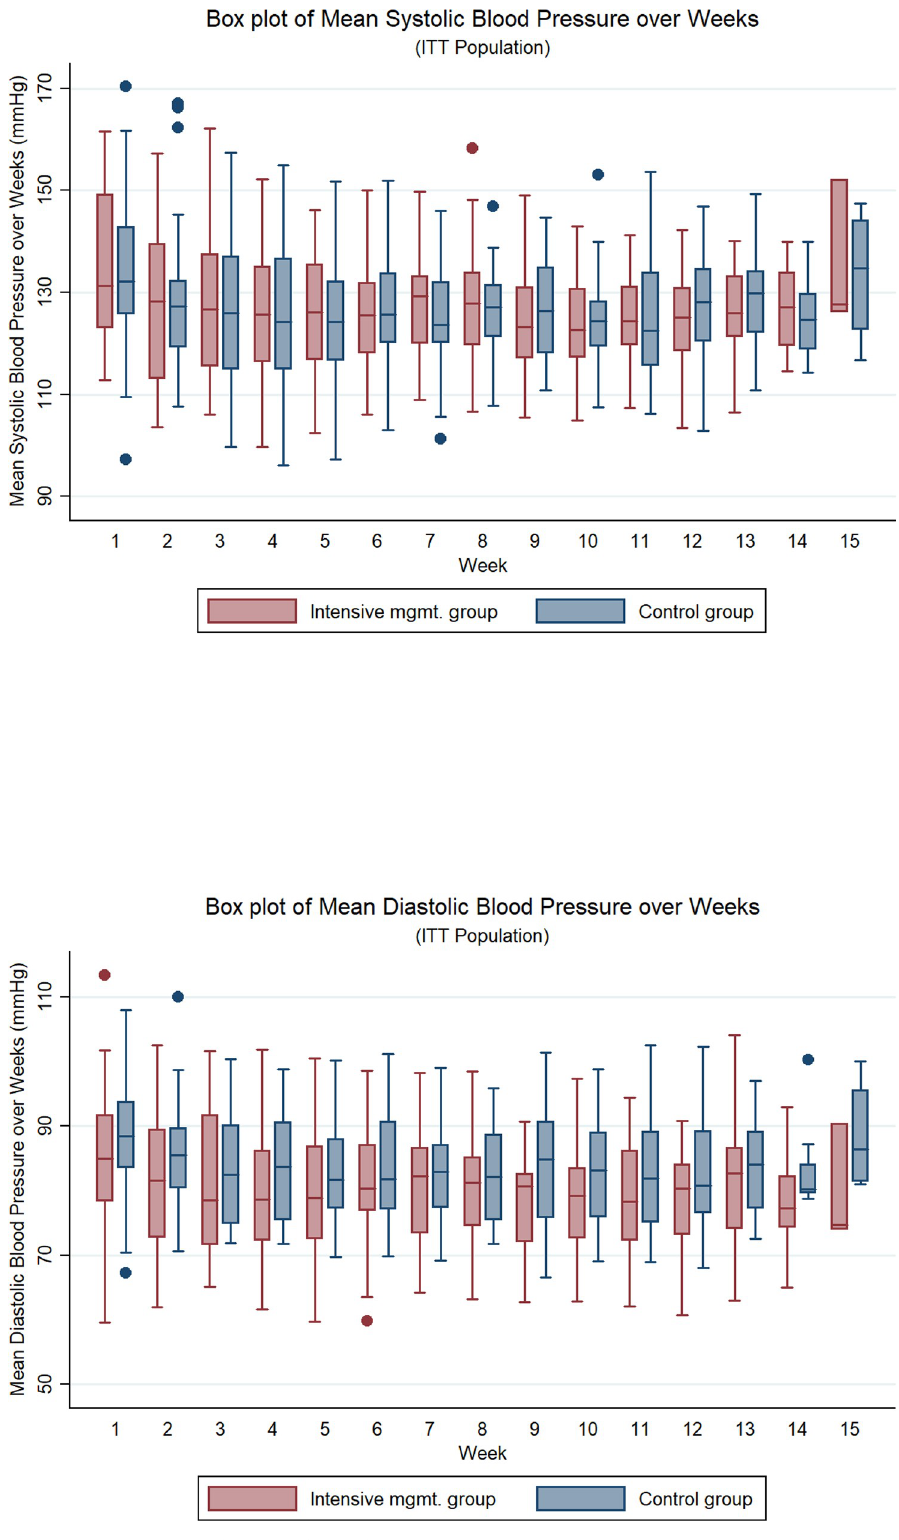
Fig 4. BP measurements during trial